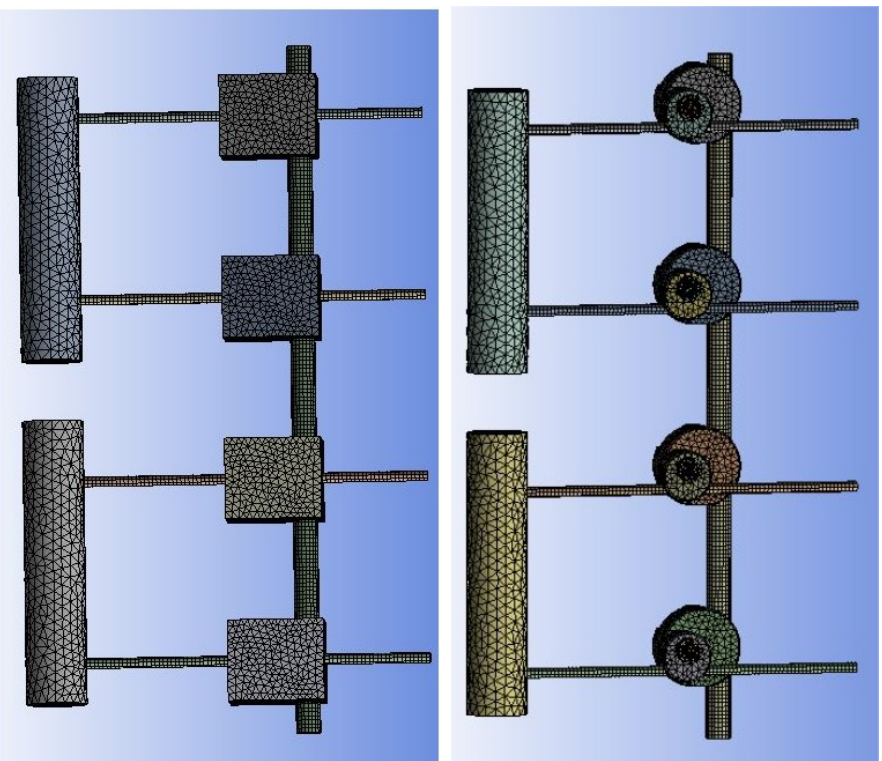
Figure 13. Meshed models for finite element analysis using the simplified model and geometry specific